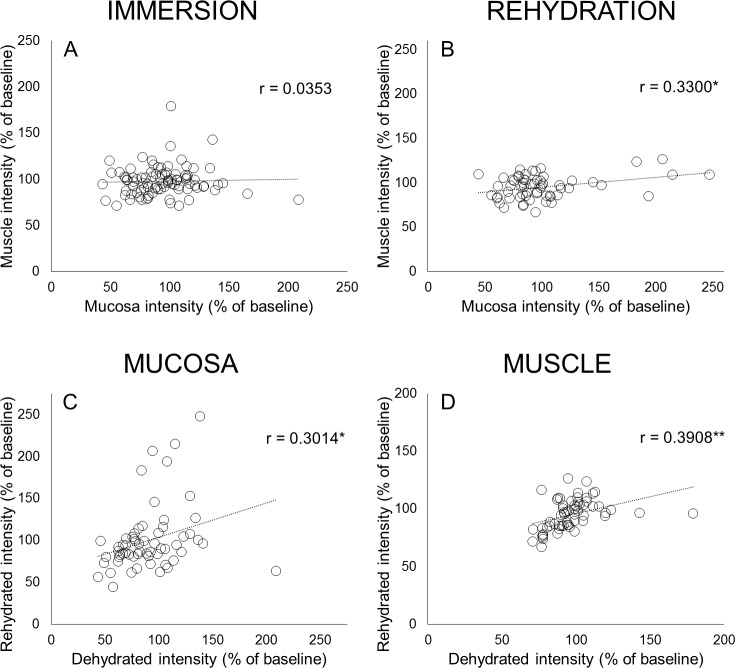
Correlations between intensity changes between tissues and across conditions.(A-B): Correlation between intensity (% of baseline) in mucosa and thyroarytenoid muscle after immersion (A) and after rehydration (B). (C-D): Correlation between intensity (% of baseline) after dehydration and after rehydration in mucosa (C) and muscle (D). Pearson correlation coefficient: *p < .05, **p<0.01.